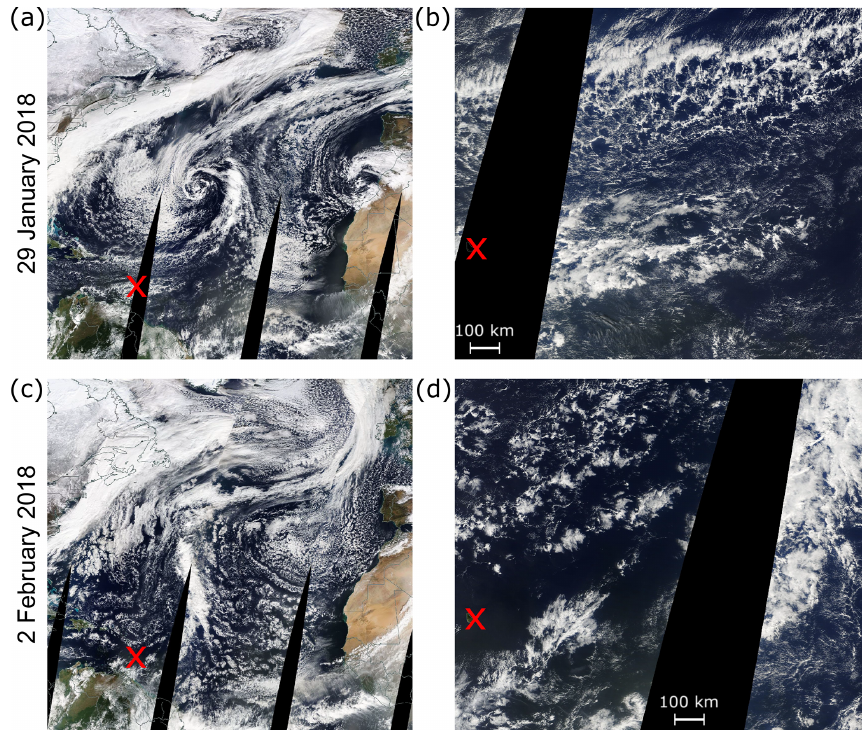
Figure 10. Cloud patterns (a, c) over the North Atlantic and (b, d) 10–20 ◦ N, 48–60 ◦ W, around Barbados, at 14:30UTC on 29 Jan- uary 2018 (a, b) and 14:30UTC on 2 February 2018 (c, d) as seen from the MODIS instrument on TERRA. Images from NASA Worldview Snapshots (https://wvs.earthdata.nasa.gov, last access: 10 January 2021). In (a) the cyclone is visible that is associated with the extratropical dry intrusion reaching Barbados a few days later on 1–4 February